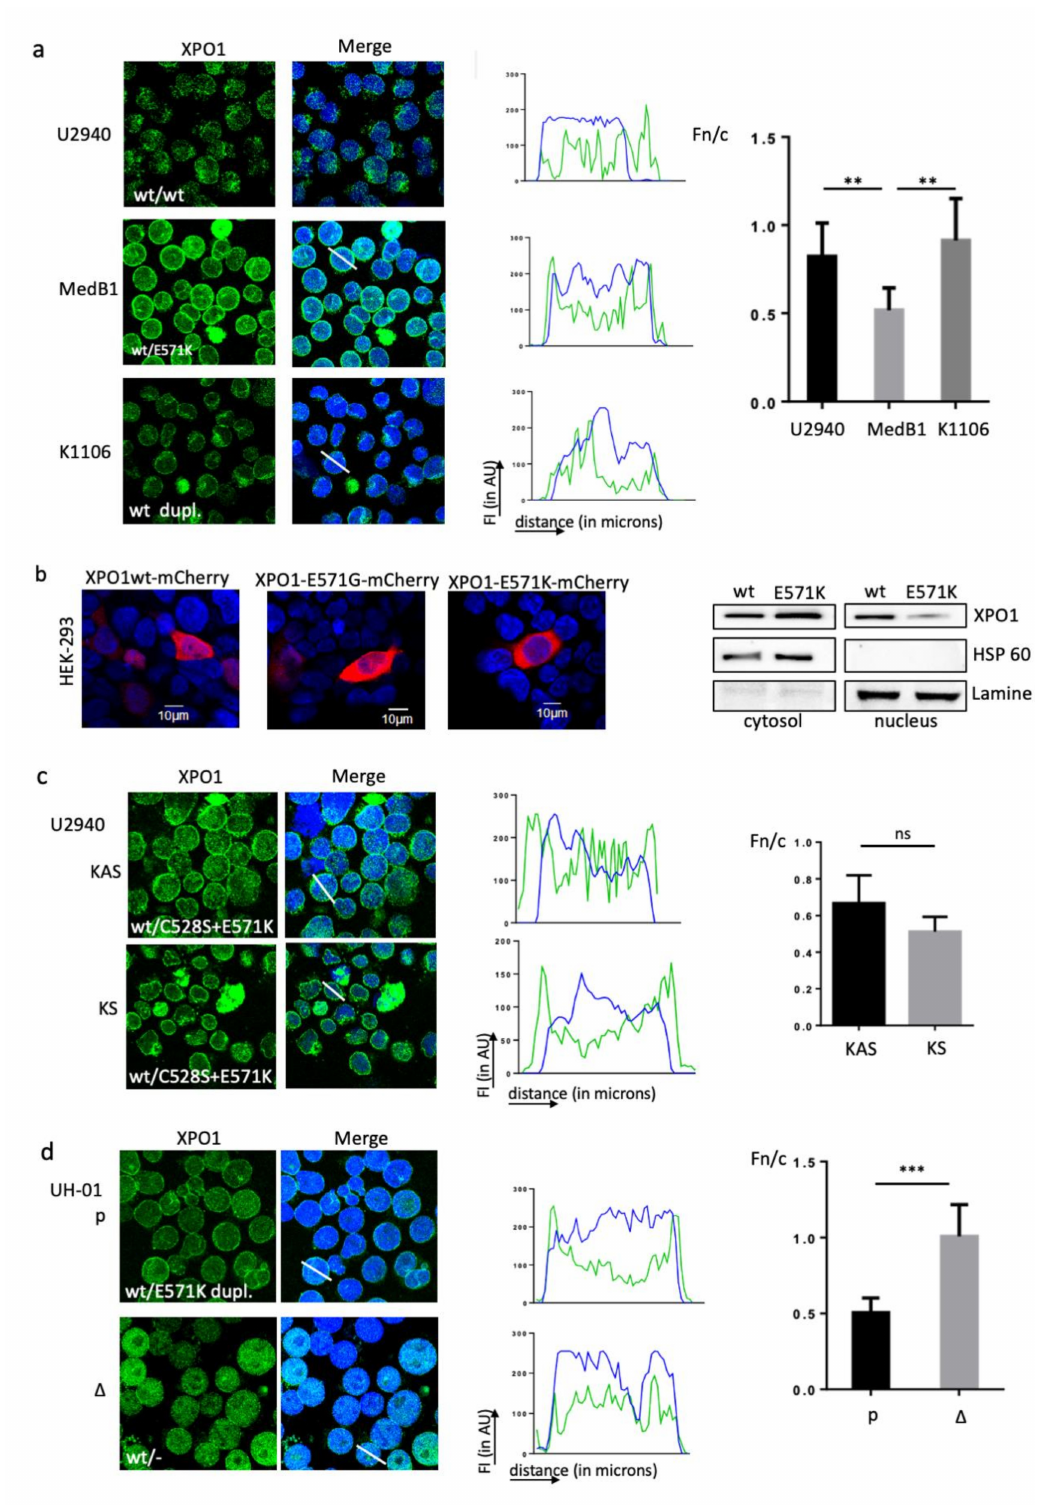
Figure 4. XPO1 accumulates at the perinuclear rim in XPO1 E571K -expressing cells. ( a ) PMBL cells were analysed by IF to determine the localisation of XPO1. We used an anti-XPO1 Ab (Table S7) and a goat Alexa Fluor 488-conjugated anti-rabbit IgG as the secondary Ab. Slides were counterstained with DAPI and analysed by confocal microscopy ( × 180 magnification). Images were processed with the